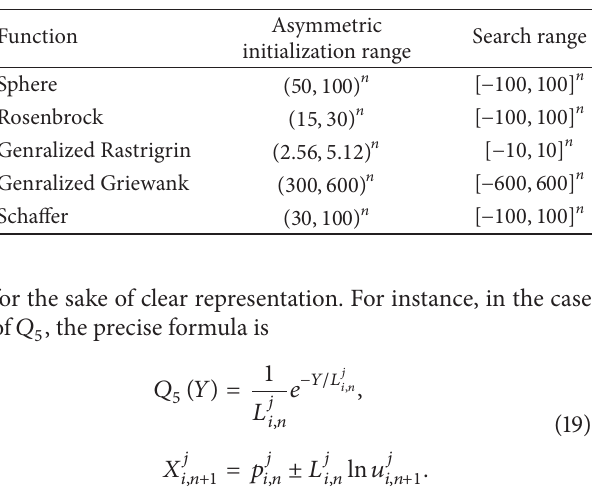
Figure 4: Figure of the probability density function 𝑄 4 .